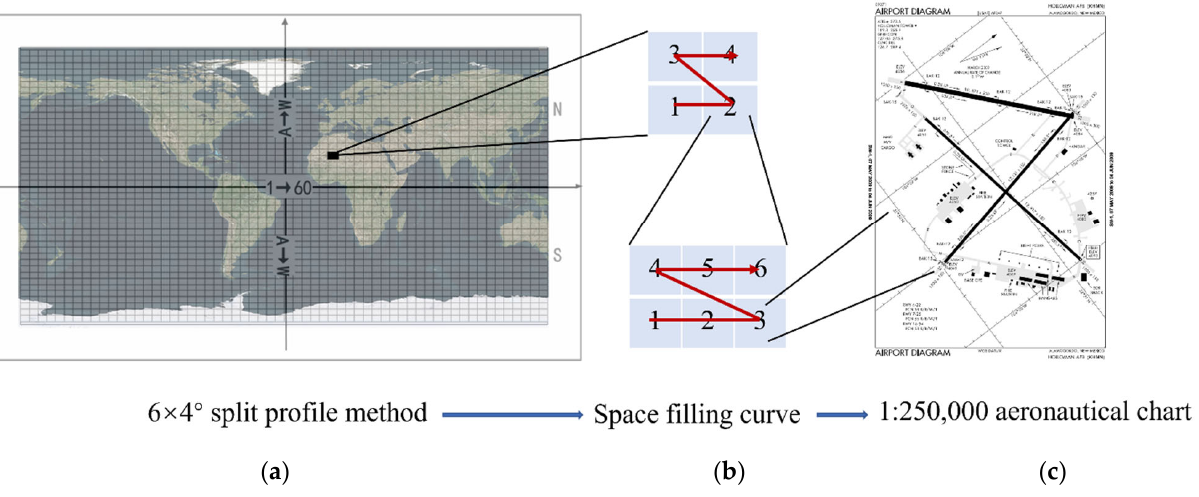
Figure 2. ( a ) 6 × 4° profile structure of the primary grid (1st level profile); ( b ) The order of the codes represented by the space ‐ filling curves (2nd and 3rd level profile); ( c ) Aeronautical maps of the corresponding scale.